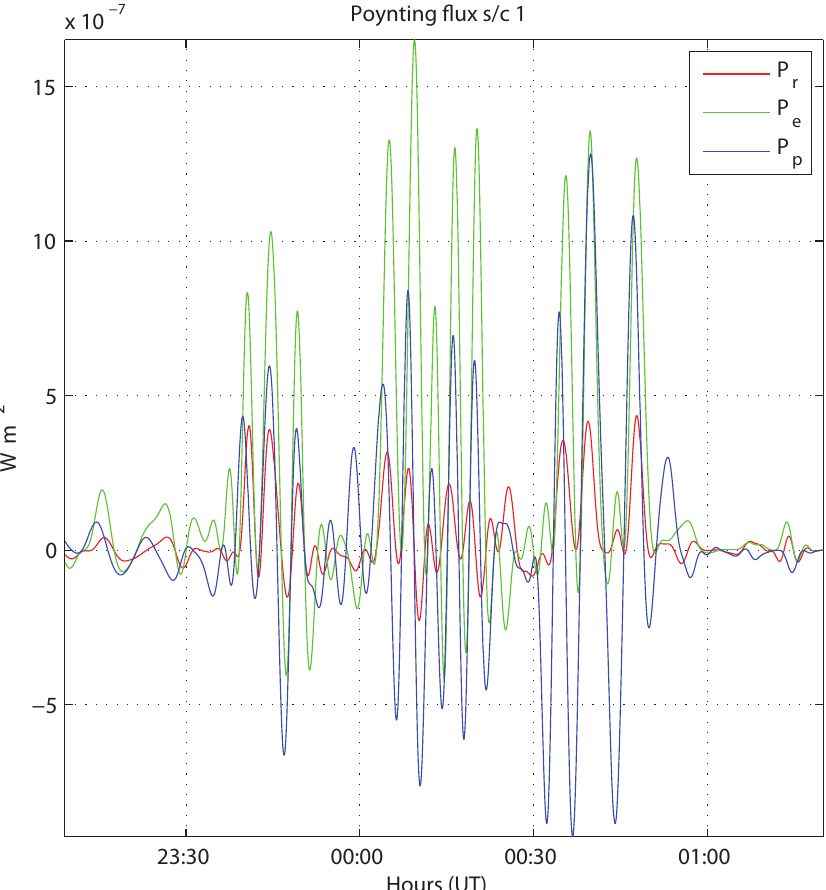
Fig. 7. Poynting flux in field-aligned coordinates calculated from s/c 1. Blue line is the field-aligned component, green the eastward component and red the radial